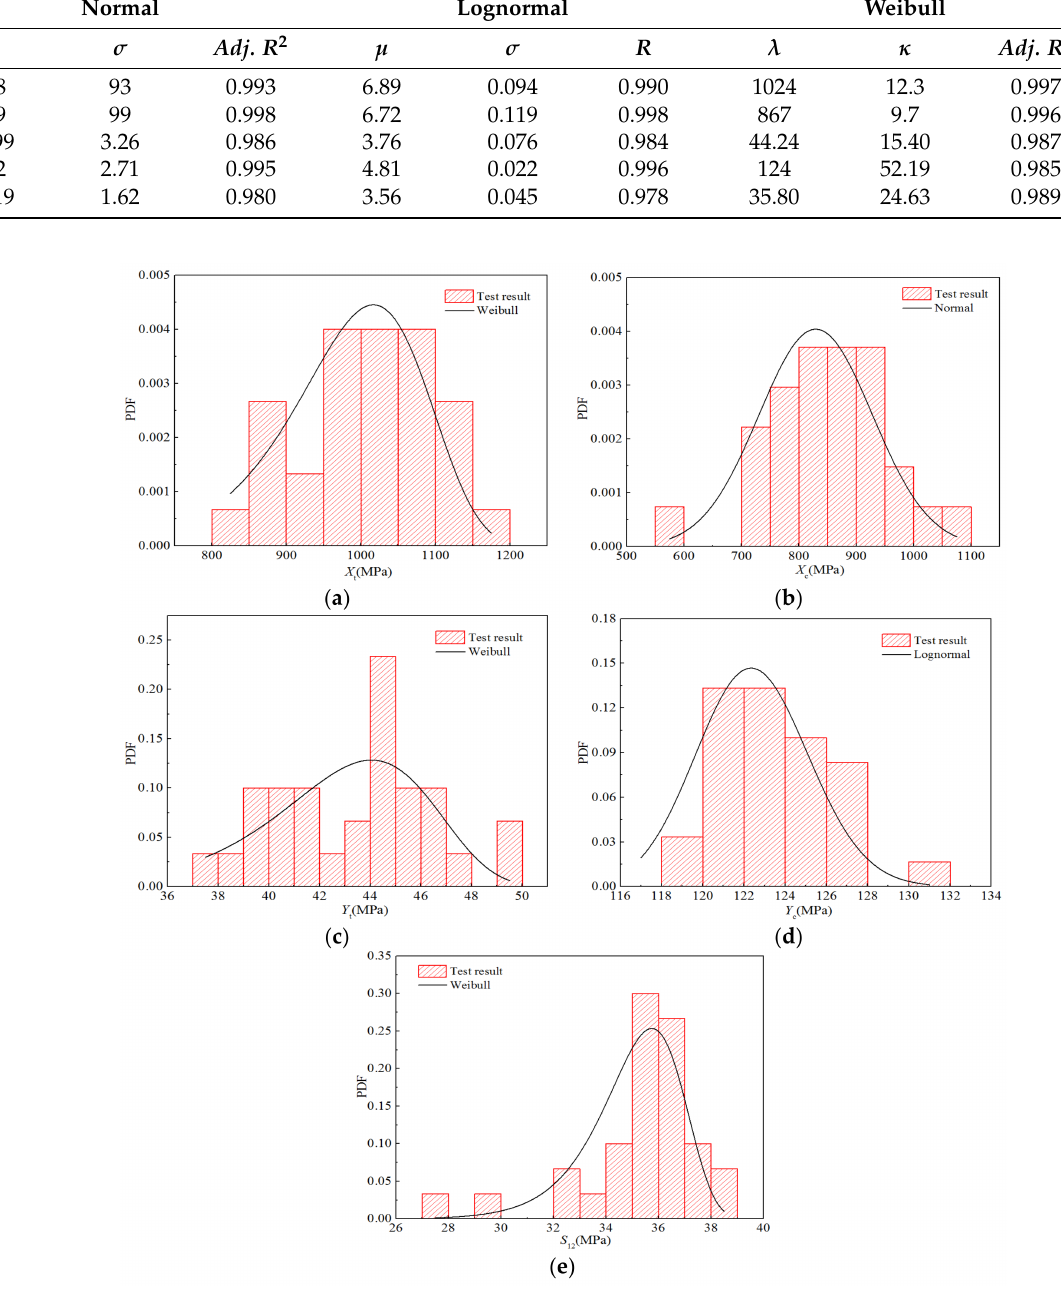
Figure 13. Probability distribution diagrams for the strength properties of H-GFRPs under the ETW condition. ( a ) X t , ( b ) X c, ( c ) Y t , ( d ) Y c, ( e ) S 12